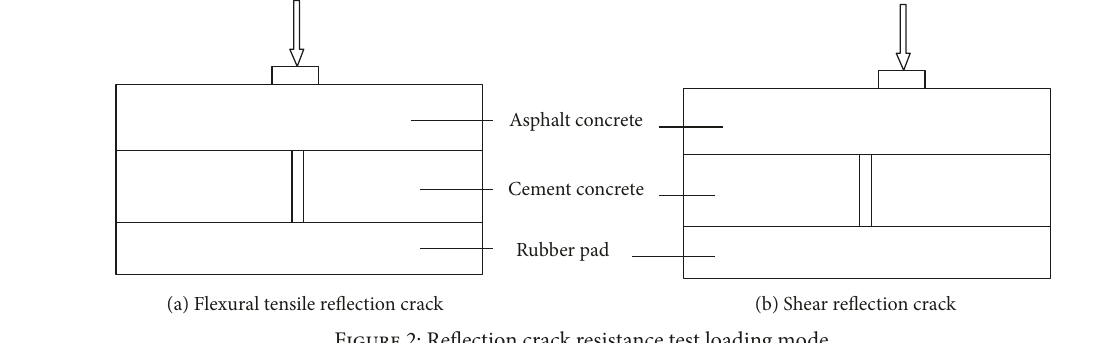
Figure 2: Reflection crack resistance test loading mode. Table 18: Flexural tensile type reflection crack.